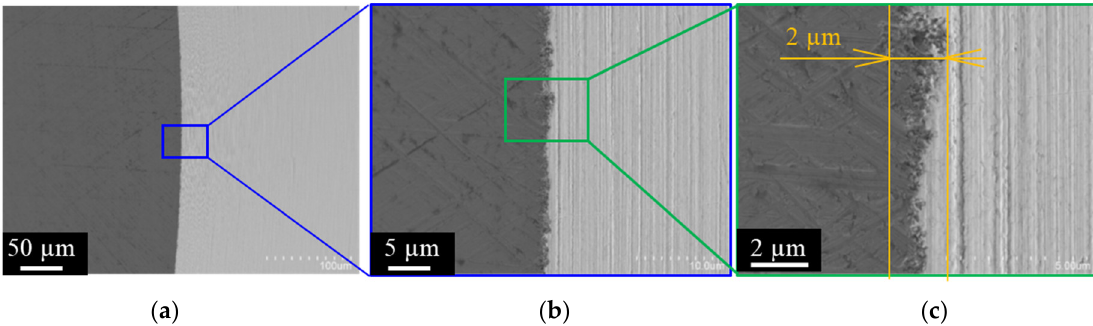
Figure 3. SEM image on the punch head and side surfaces of normally ground WC (Co) punch across the punch edge with various magnification. ( a ) Overall view of the trimmed, diamond-coated punch, ( b ) Higher magnification image on the punch edge, and ( c ) Highest magnification image on the vicinity of the edge.